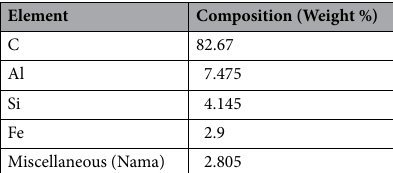
Table 1. Elemental composition of the base material.